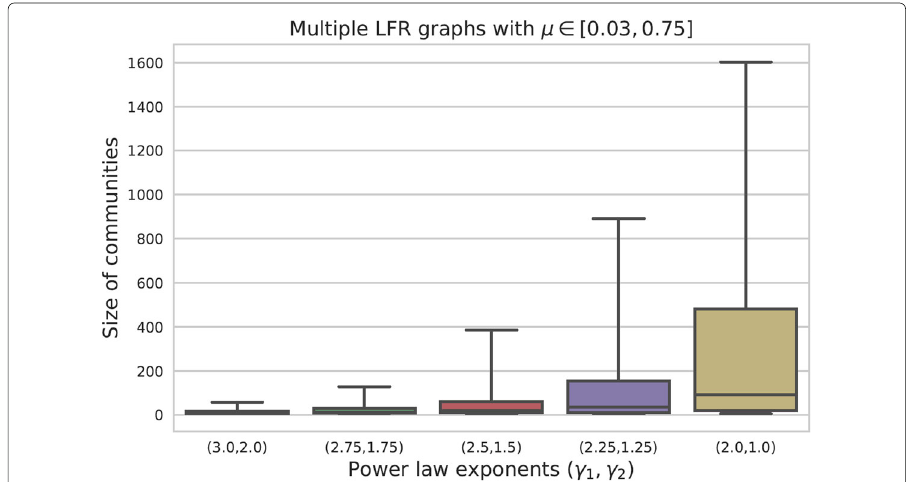
Fig. 6 We selected 5 choices for the power law parameters (γ 1 , γ 2 ) which are representative of various types ofnetworksobtainedwiththeLFRbenchmark, andwe lookatthe distributionofthe sizesof communities.We see that with the largest recommended values (γ 1 , γ 2 ) = ( 3,2 ) , we get small communities of homogeneous size. As the exponents decrease, the sizes of the communities get more heterogeneous. All results were obtained by averaging over 10 graphs with 22,186 nodes for every choice of parameters (μ , γ 1 , γ 2 )